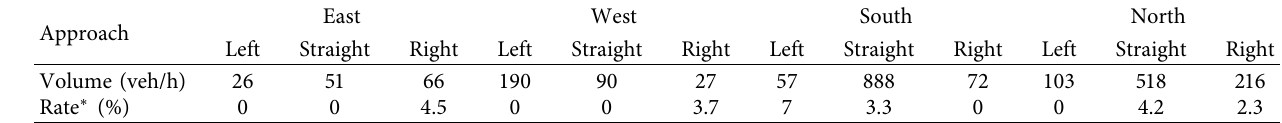
Table 2: Volumes and large vehicle rates.